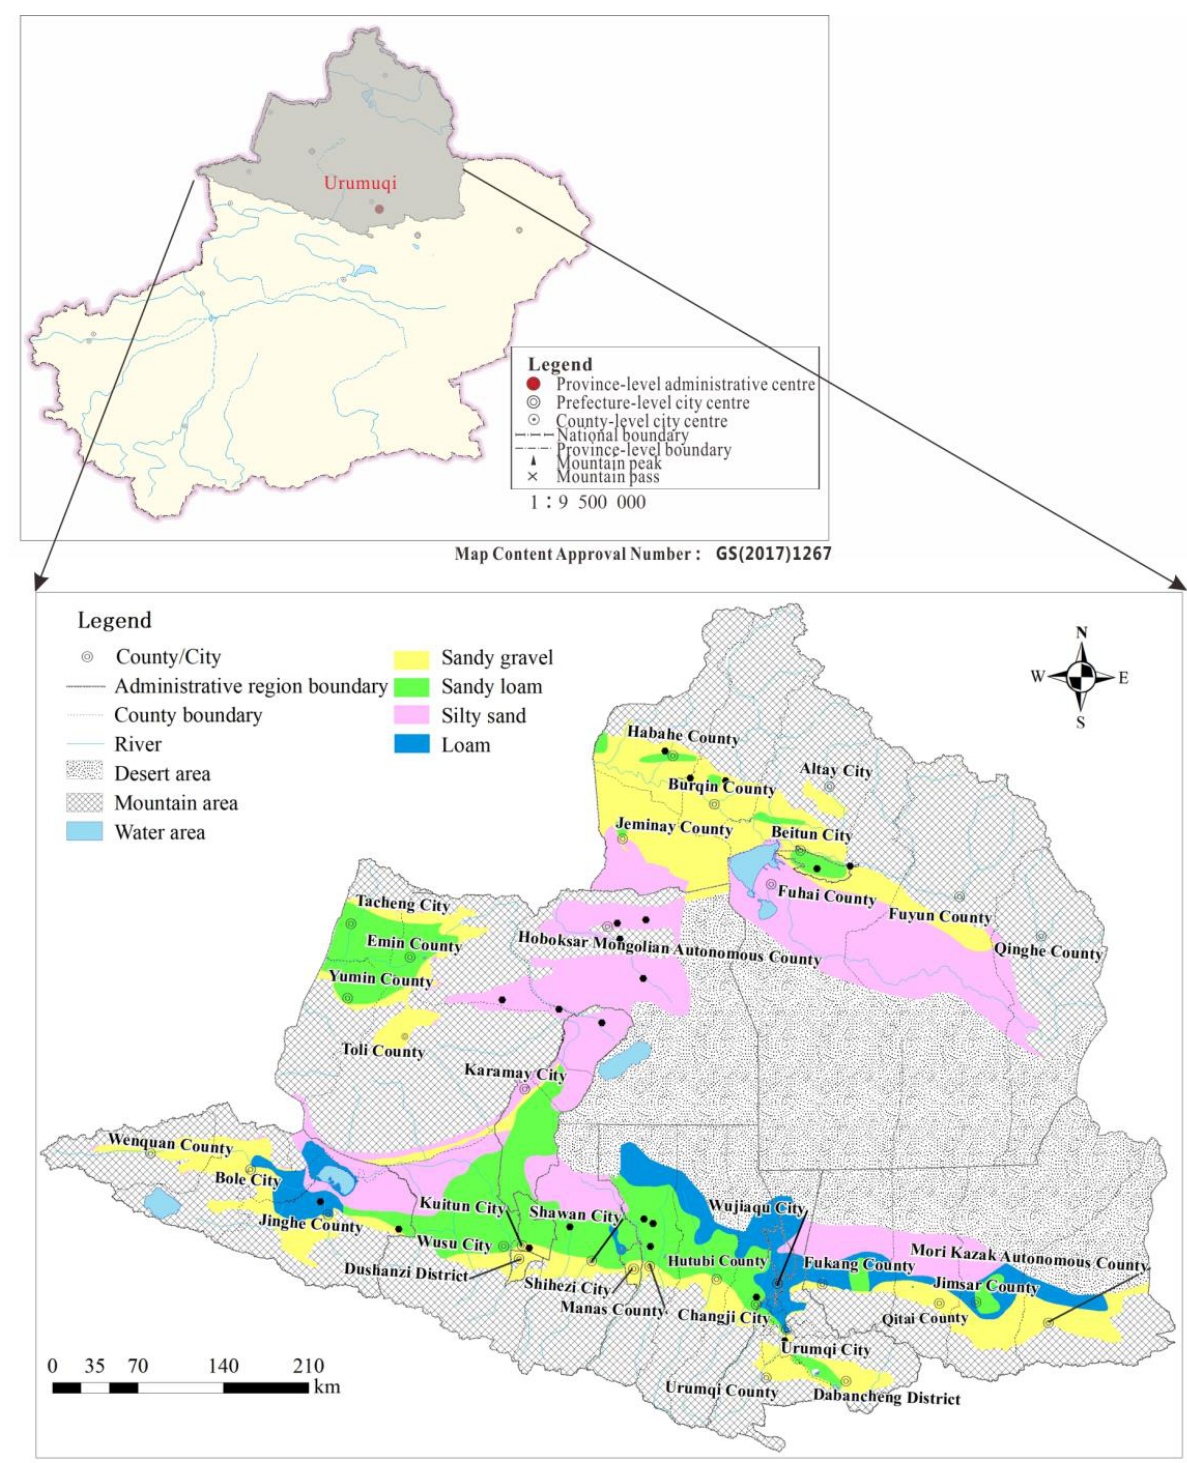
Figure 1. Lithology of vadose zone in the Junggar Basin.